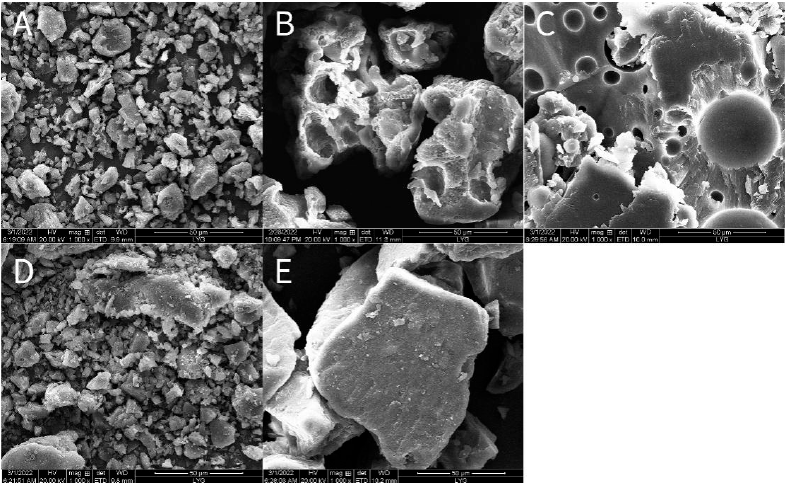
Figure 16. SEM microscopy of PCE ( A ), HPMCAS ( B ), P188 ( C ), PM ( D ) and PCE-SD ( E ).